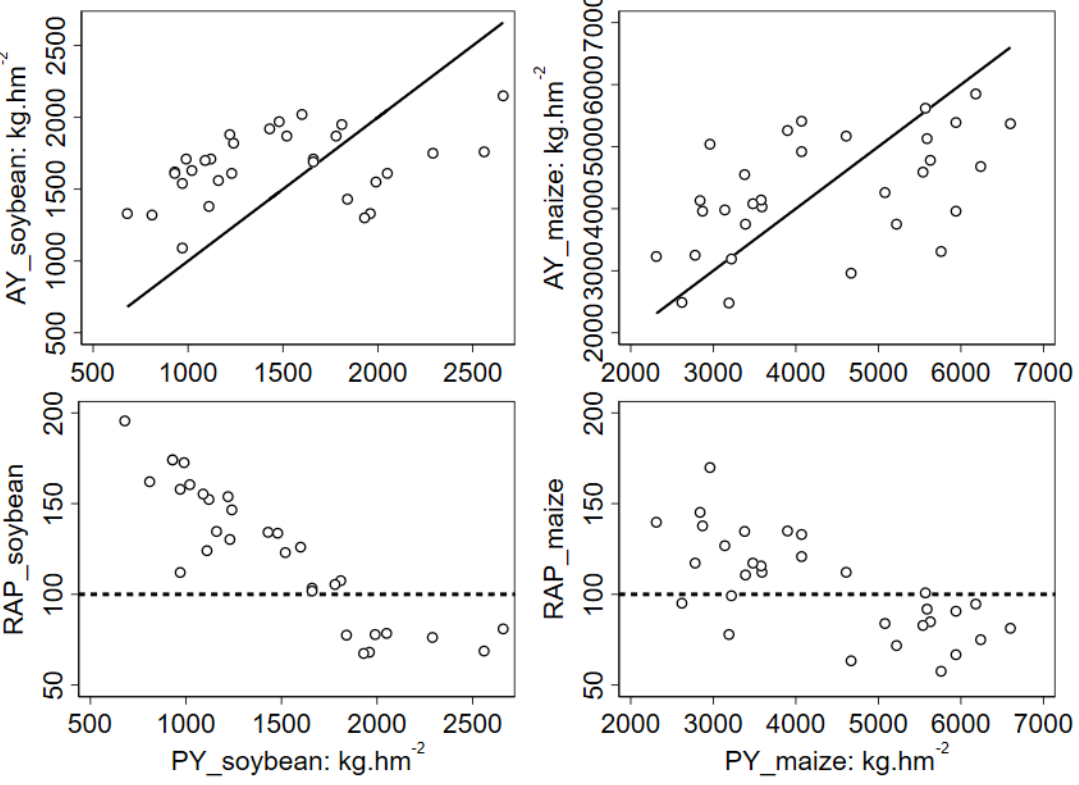
Figure 2. Relationship between PY and AY for soybeans and maize in provinces in China .